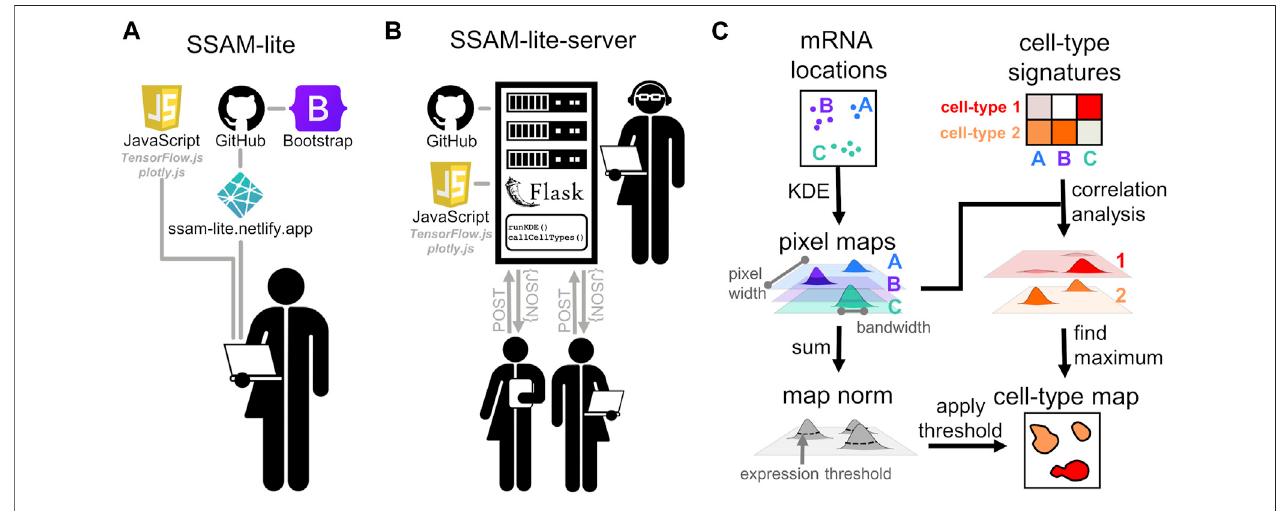
FIGURE1| SchematicofSSAM-lite. (A) SchematicdiagramofSSAM-lite,accessibleasawebbrowserapplication,and (B) alocallyinstalledSSAM-lite-server. (C) Schematic of the underlying data processing algorithm proposed by